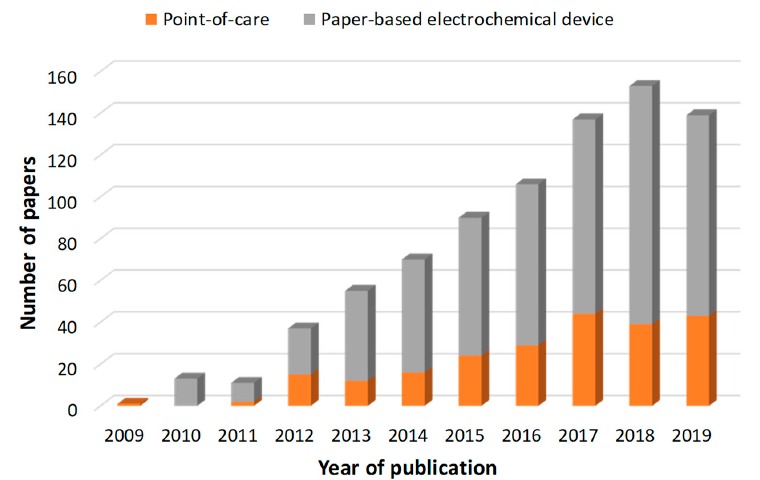
Figure 1. Annual trend in the number of publications for “paper-based electrochemical device” (grey) and “point-of-care” applications (orange) from 2009 to 2019. Database: Web of Science Core Collection.